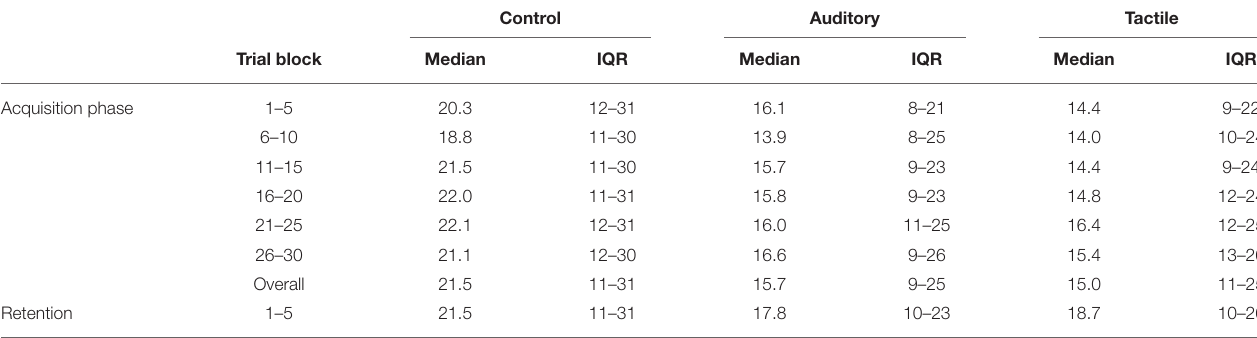
TABLE 1 | Peak sacro-lumbar flexion angle expressed as median and interquartile range (Q1–Q3) across the experimental conditions and trial blocks. Control Auditory